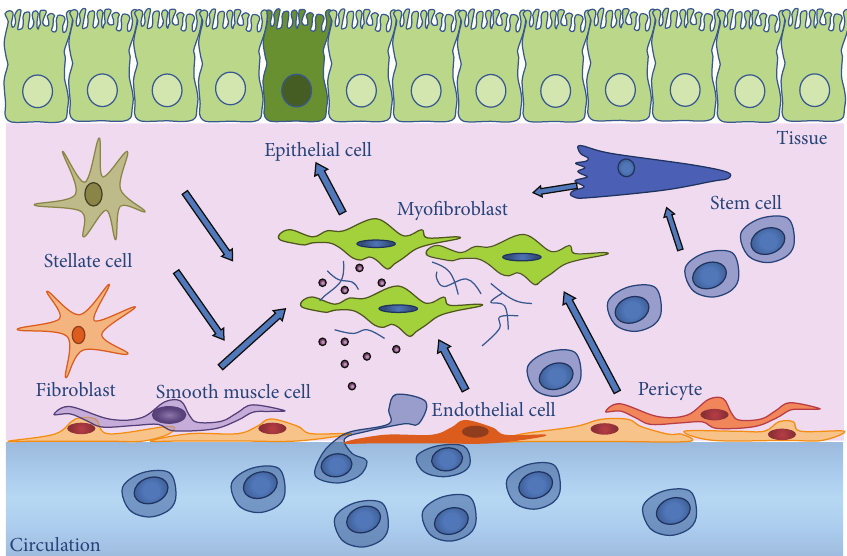
Figure 1: Hypothetical origin of